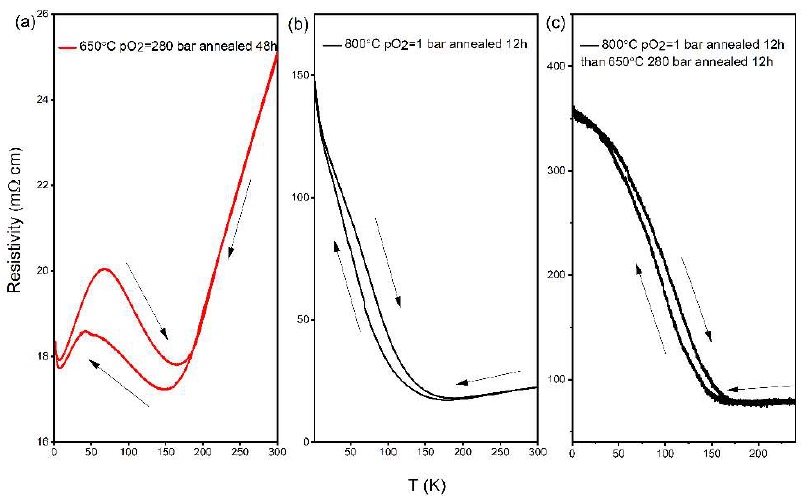
Figure 4. The resistivity of NdNiO 3 from three samples: ( a ) annealed at 650 °C for 48 h under pO 2 = 280 bar, ( b ) annealed at 800 °C for 12 h under pO 2 = 1 bar, and ( c ) initially annealed at 800 °C for 12 h under pO 2 = 1 bar and then at 650 °C for 12 h under pO 2 = 280 bar. Arrow indicates heating/cooling process.